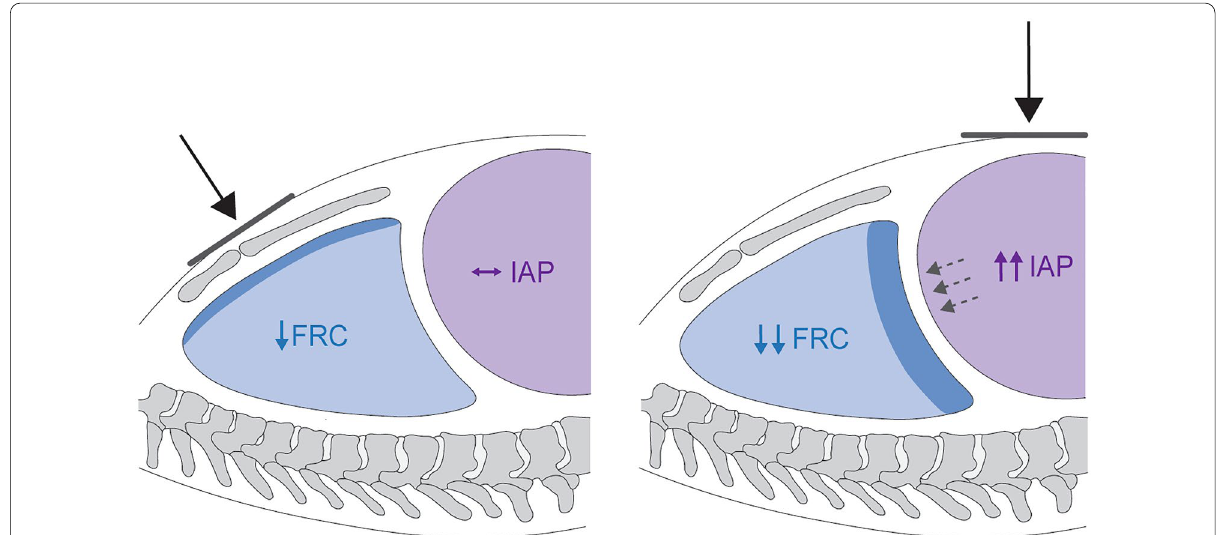
Fig. 3 Differential effects of regional chest wall loading. Selective compression of the supradiaphragmatic compartment (left panel) is expected to result in relatively minimal loss (darker blue) of resting lung volume (functional residual capacity, FRC) or change in intra-abdominal pressure (IAP). In contrast, selective compression of the infradiaphragmatic compartment (right panel) increases IAP and displaces the diaphragm cephalad (dashed arrows), resulting in comparatively greater loss (darker blue) of resting lung volume (lighter blue). In the setting of widespread